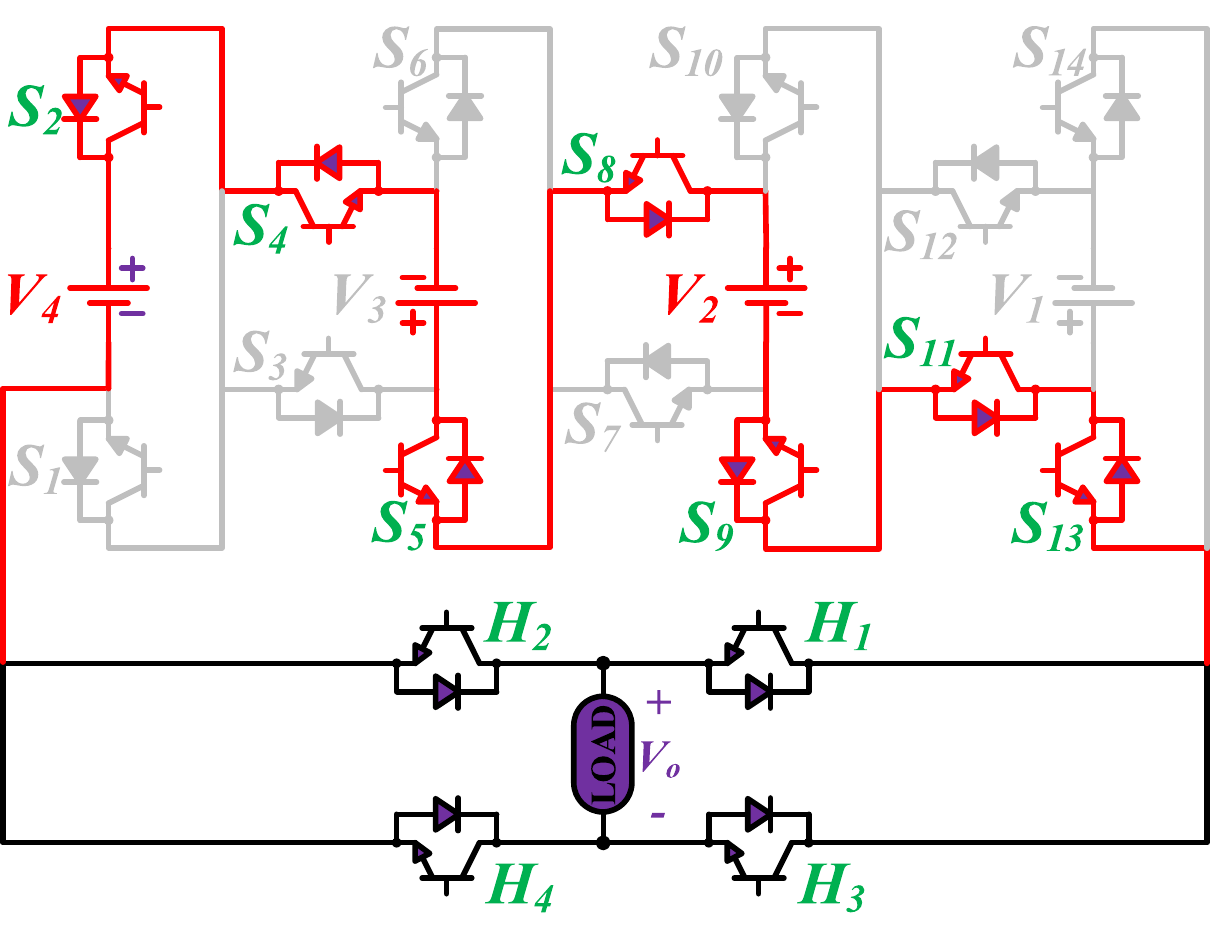
Fig 11. Switching states for voltage magnitude level